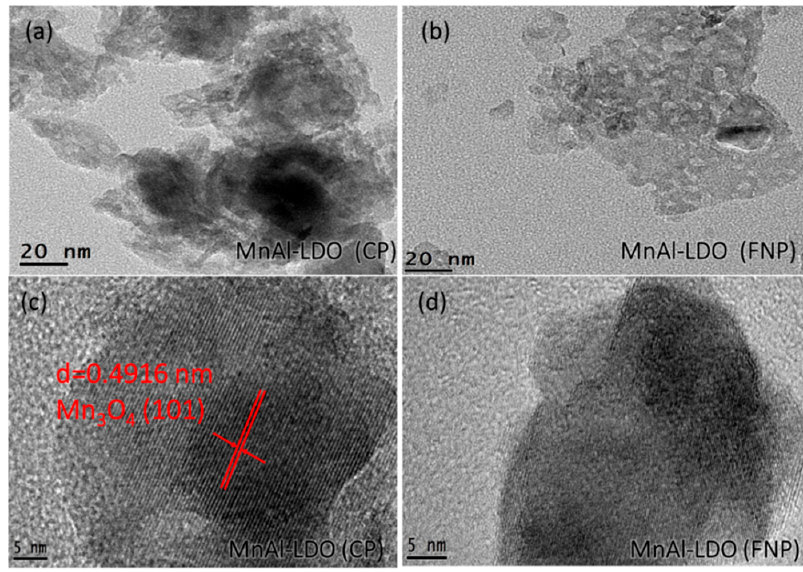
Figure 2. HR-TEM images of MnAl-LDO (CP) and MnAl-LDO (FNP) catalysts.